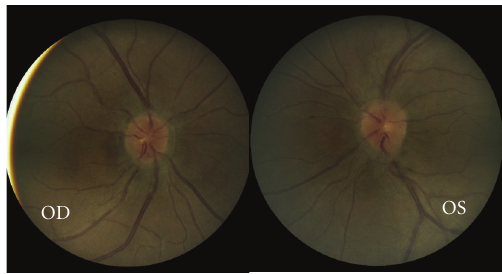
Figure 1: Color fundus photographs of the right and left optic nerves.